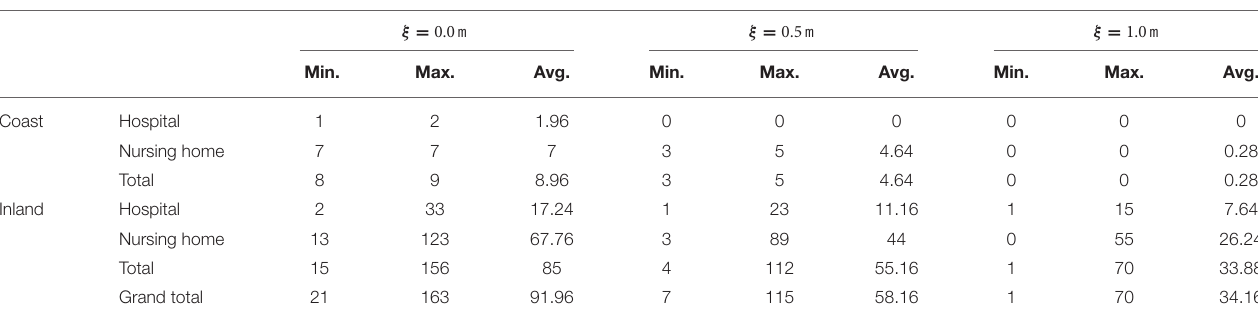
TABLE 3 | Number of flooded locations in different threshold levels ( ξ ). ξ = 0.0 m ξ = 0.5 m ξ = 1.0